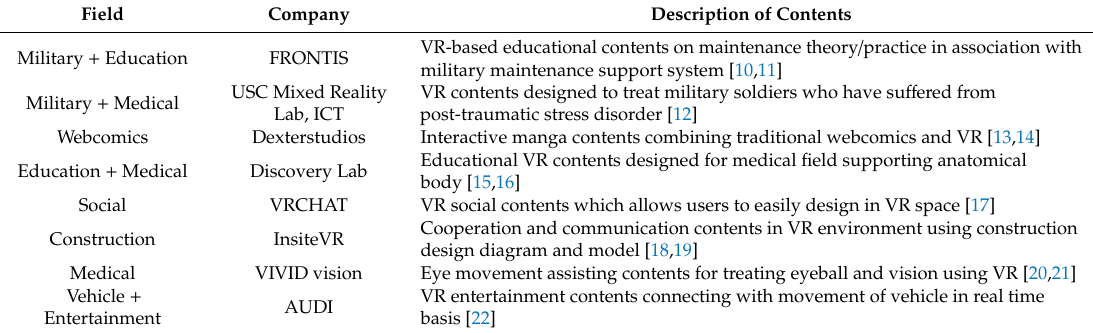
Table 1. Virtual Reality (VR) contents industry